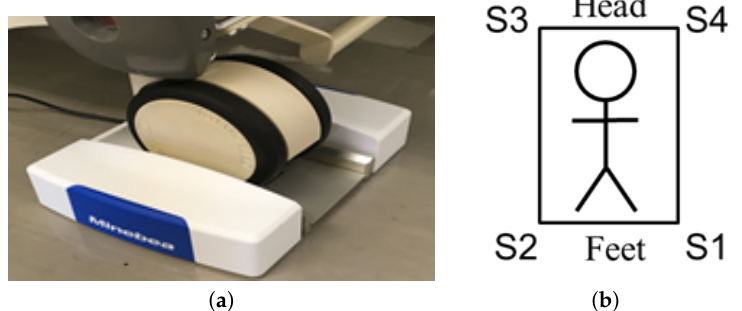
Figure 2. Bed sensor system: ( a ) a photograph of the bed leg sensor used in this study; this sensor was placed under each of the bed leg. Figure courtesy of MiuebeaMitsumi Inc; ( b ) the ID numbers assigned to each